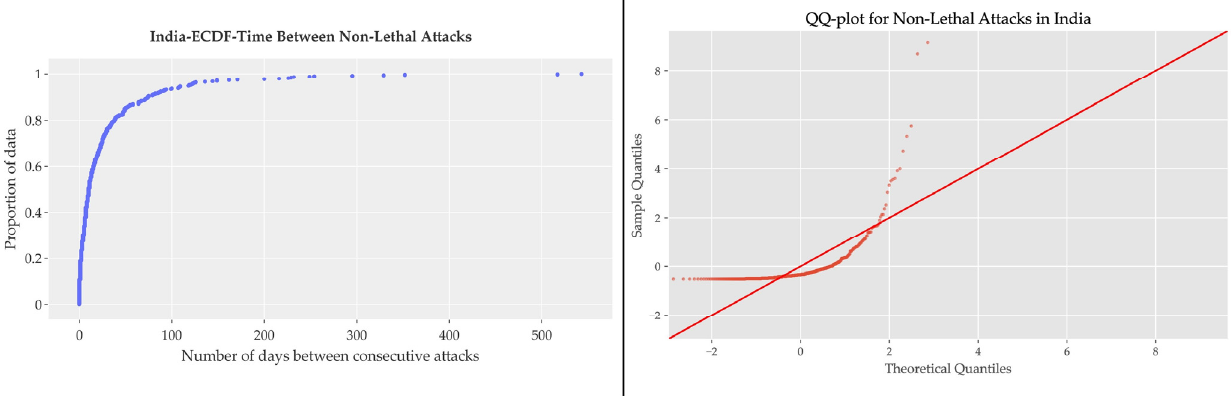
Figure 13. The time between consecutive lethal attacks and the corresponding QQ plot for India.